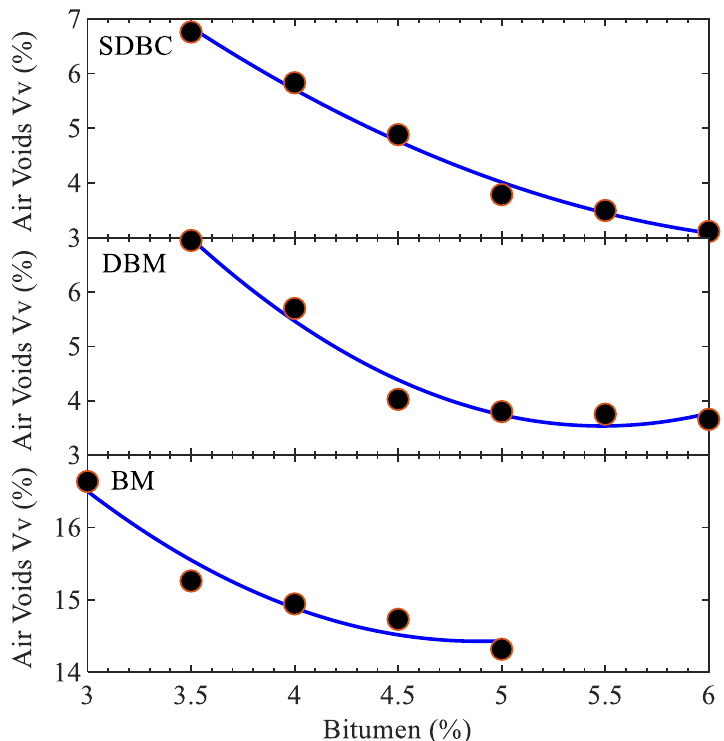
Fig. 9 Relations between air voids with bitumen content for SDBC, DBM, and BM